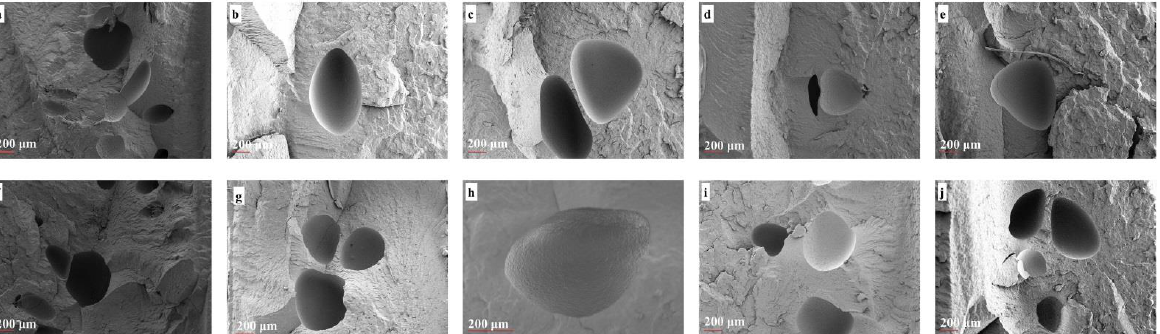
Figure 5. SEM images with magnification of 200 of ( a ) neat co-PP foam; ( b ) 1 wt % xGnP incorporated